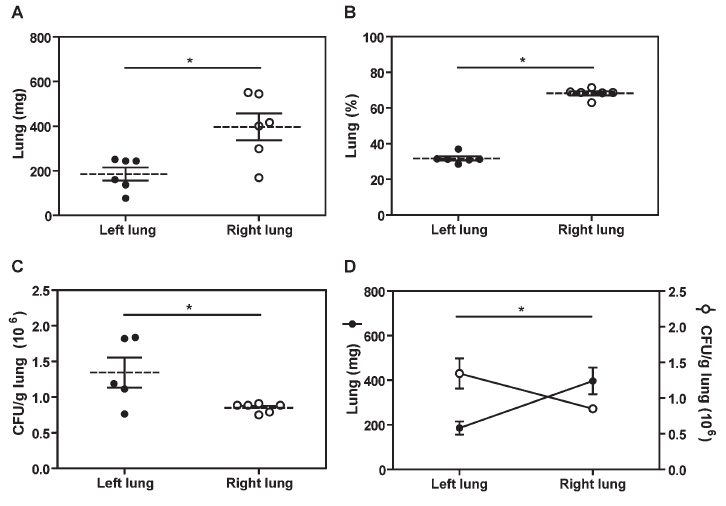
Figure 1. Increased fungal recovery in the left lung of Paracoccidioides brasiliensis -infected mice. Male C57BL/6 mice were challenged intravenously with 1 6 10 6 viable P. brasiliensis 18 (Pb18) yeast cells. A , The right and left lungs were weighed individually at day 70 post-infec- tion. B , Percent weight of each lung. C , Number of colony-forming units (CFU) was determined individually for each lung. D , Inverse correlation between the weight of the lungs and the CFU recovered from the pulmonary tissues. Data are reported as means±SE of 6 mice. *P # 0.05 (ANOVA followed by the parametric Tukey- Kramer